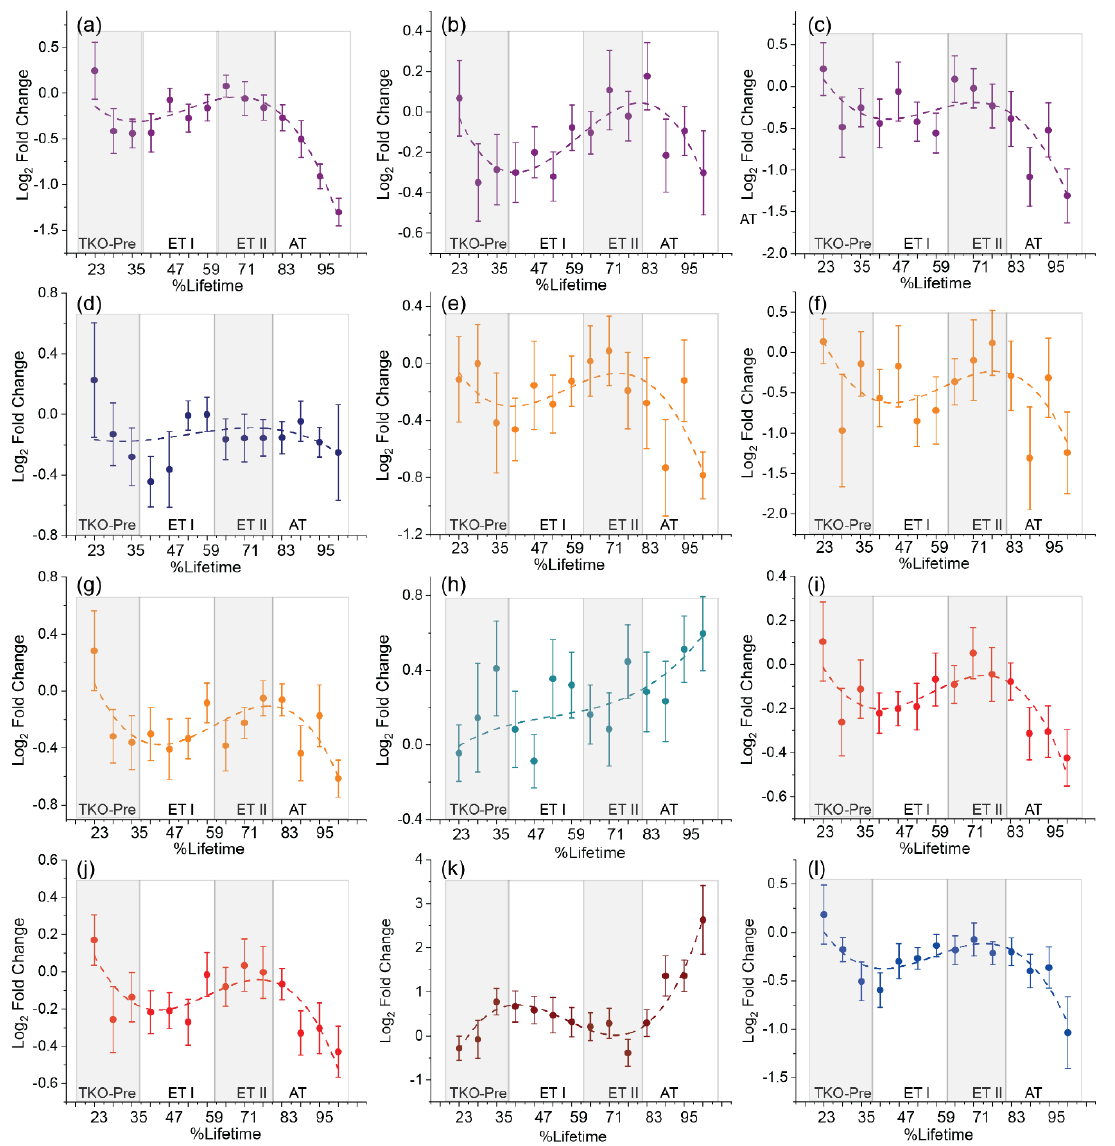
Figure 2. Time − resolved serum metabolomics results for select polar metabolites. Serum abundance fold-changes as a function of %lifetime for ( a ) serine ( b ) threonine ( c ) oxobutanoate ( d ) tryptophan ( e ) oxoglutaric acid ( f ) malic acid ( g ) citric/isocitric acid ( h ) N-acetylglutamine ( i ) citrulline ( j ) ornithine ( k ) bile acids and derivatives and ( l ) arachidonic acid metabolites. The x -axis shows the %lifetime, calculated as the ratio of the age of mouse at a given serum sampling time point compared to the total lifespan of that specific mouse. The y -axis shows the fold change calculated as the base 2 logarithm of the average abundance ratios between TKO and TKO control samples. Positive values indicate higher serum levels in TKO animals, and negative values indicate lower serum levels in TKO animals compared to TKO control. Error bars represent the standard error of the log 2 fold change between TKO and ctrl samples. HGSC stage estimate at different %lifetimes are shown. TKO-pre corresponds to premalignant stages, ET-I is early stage 1, ET-II is early stage II and AT is advanced stage.